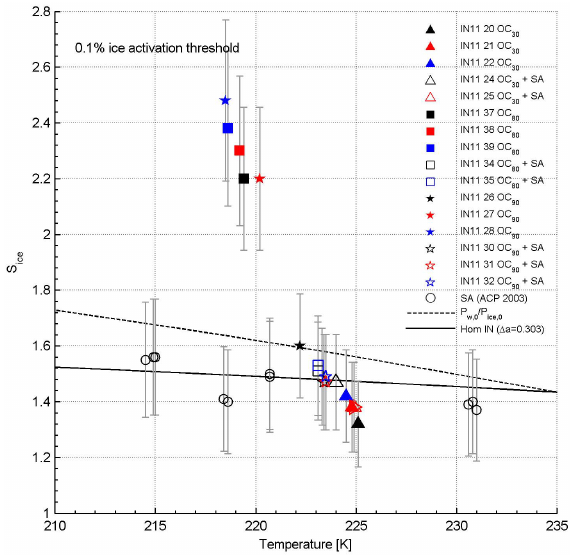
Fig. 9. Onset of freezing where 0.1% of the aerosol population become ice active for OC 30 , OC 80 and OC 90 flame soot with (un- filled markers) and without (filled markers) a sulphuric acid coat- ing. Dashed line is water saturation; water saturation pressure pa- rameterisation given by Murphy and Koop (2005). For compari- son the homogeneous freezing of pure sulphuric acid droplets are shown from previous AIDA studies M ¨ ohler et al. (2003), labeled ACP 2003, along with the homogeneous freezing threshold of su- percooled solution droplets Koop et al. (2000), indicated by the solid